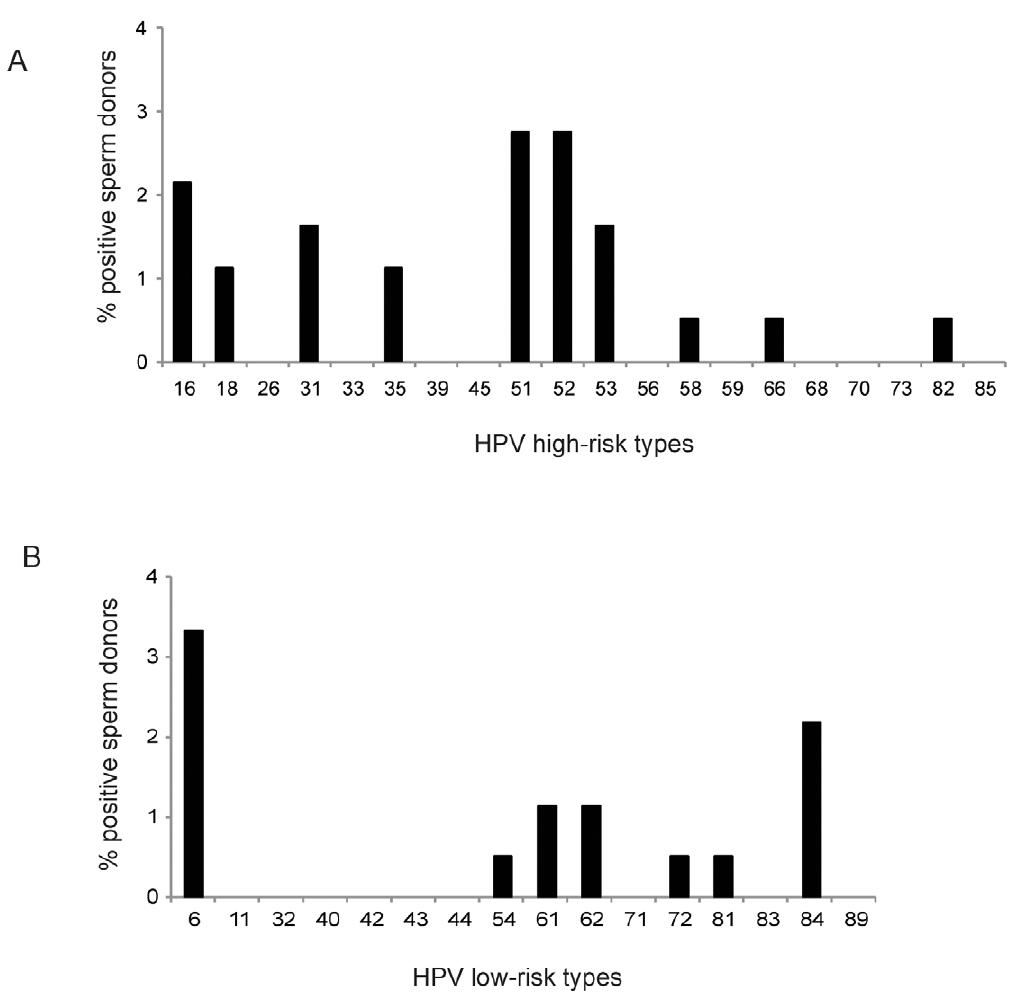
Figure 1. HPV frequency and type distribution in Danish donor semen, analyzed using a sensitive HPV type-specific array. ( A ): Frequency of twenty high-risk types, given as percent of all tested donors. ( B ): Frequency of fifteen low-risk types, given as percent of all tested donors.